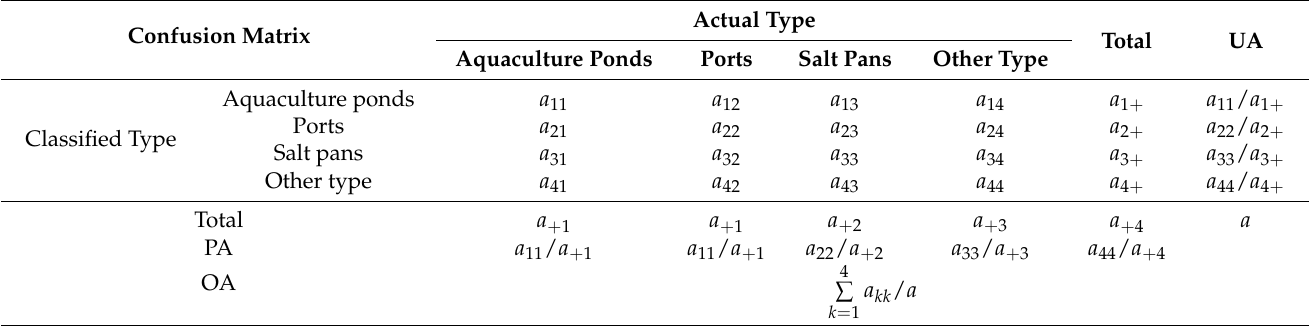
Table 3. Description of confusion matrix used to validate the accuracy of reclamation classification.